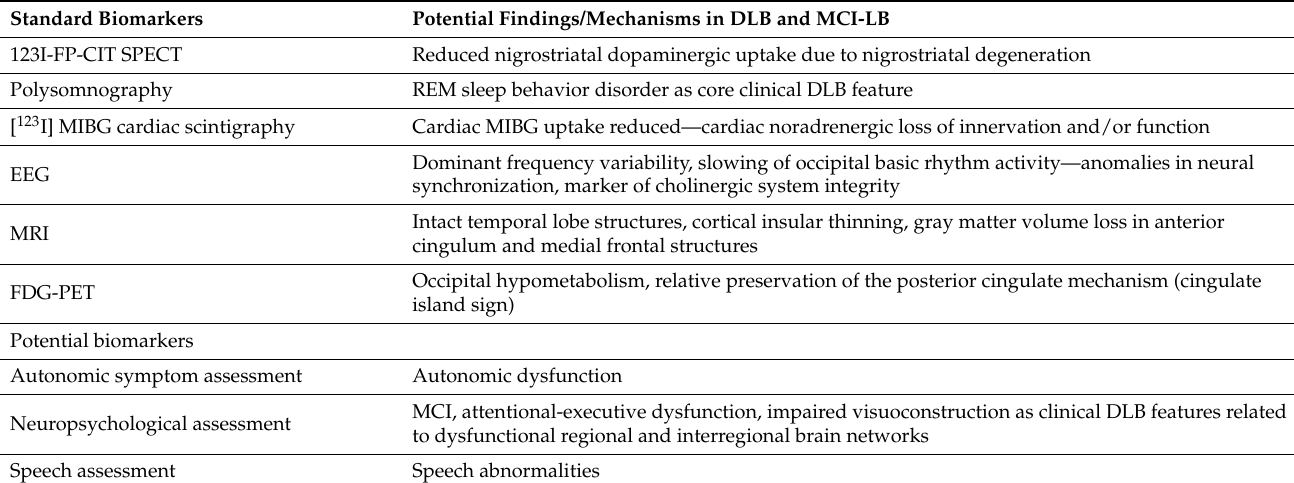
Table 3. Synopsis of established and potential biomarker of prodromal dementia with Lewy bodies with